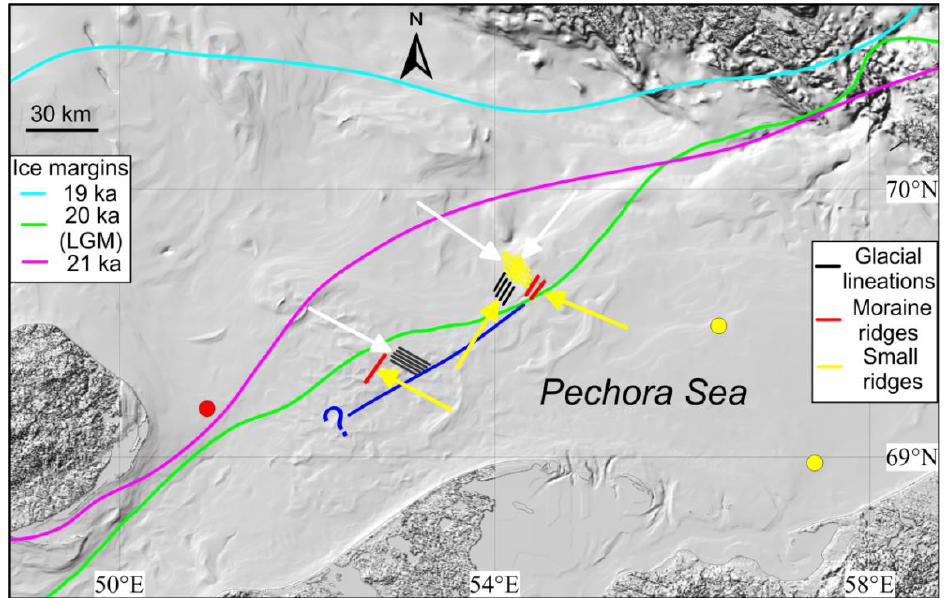
Figure 9. Distribution of submarine glacial landforms identified in the Pechora Sea. Reconstruction of the margins of the Late Weichselian ice sheet for the 21 ka, 20 ka and 19 ka BP taken from [28]. White arrows indicate the ice-flow pathways inferred from our data. Yellow arrows indicate the ice-retreat directions. The circles indicate the location of the dated cores [7]. The blue line is the minimum extent of the south-eastern margin of the Barents–Kara ice sheet during the LGM, based on our data. Our study revealed glacial landforms of various orientations, suggesting a slightly more local complex scenario of inherent phases of the advance and retreat of the ice